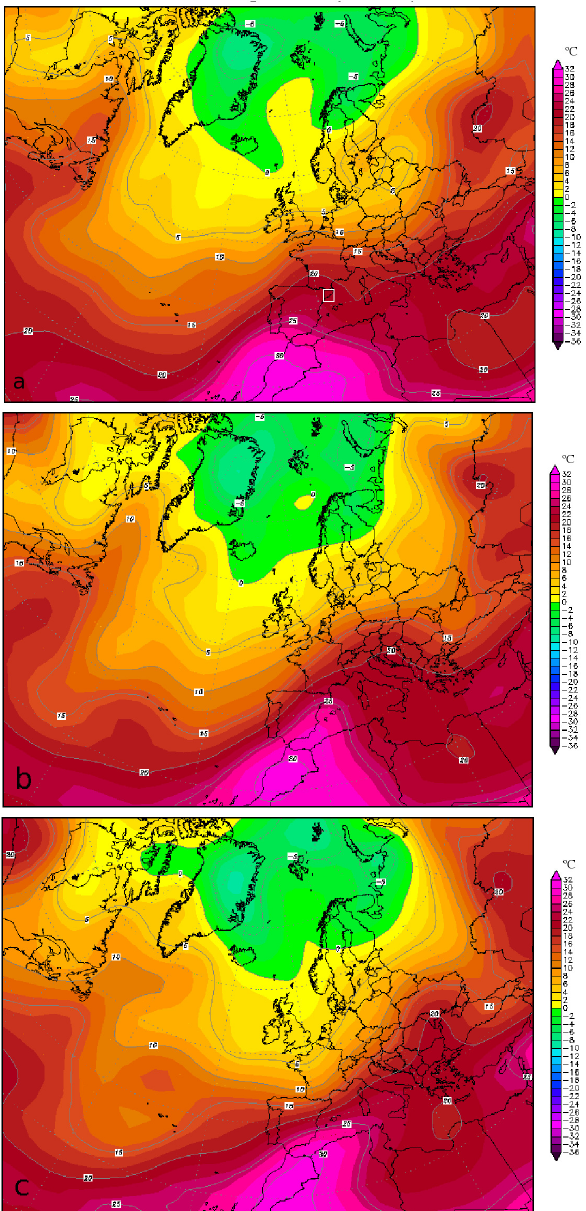
Fig. 1. Temperature at 850 hPa obtained by the NCEP reanalysis at 00:00 UTC on (a) 26, (b) 27 and (c) 28 August 2010. The white square in (a) is centered over the first area under study.